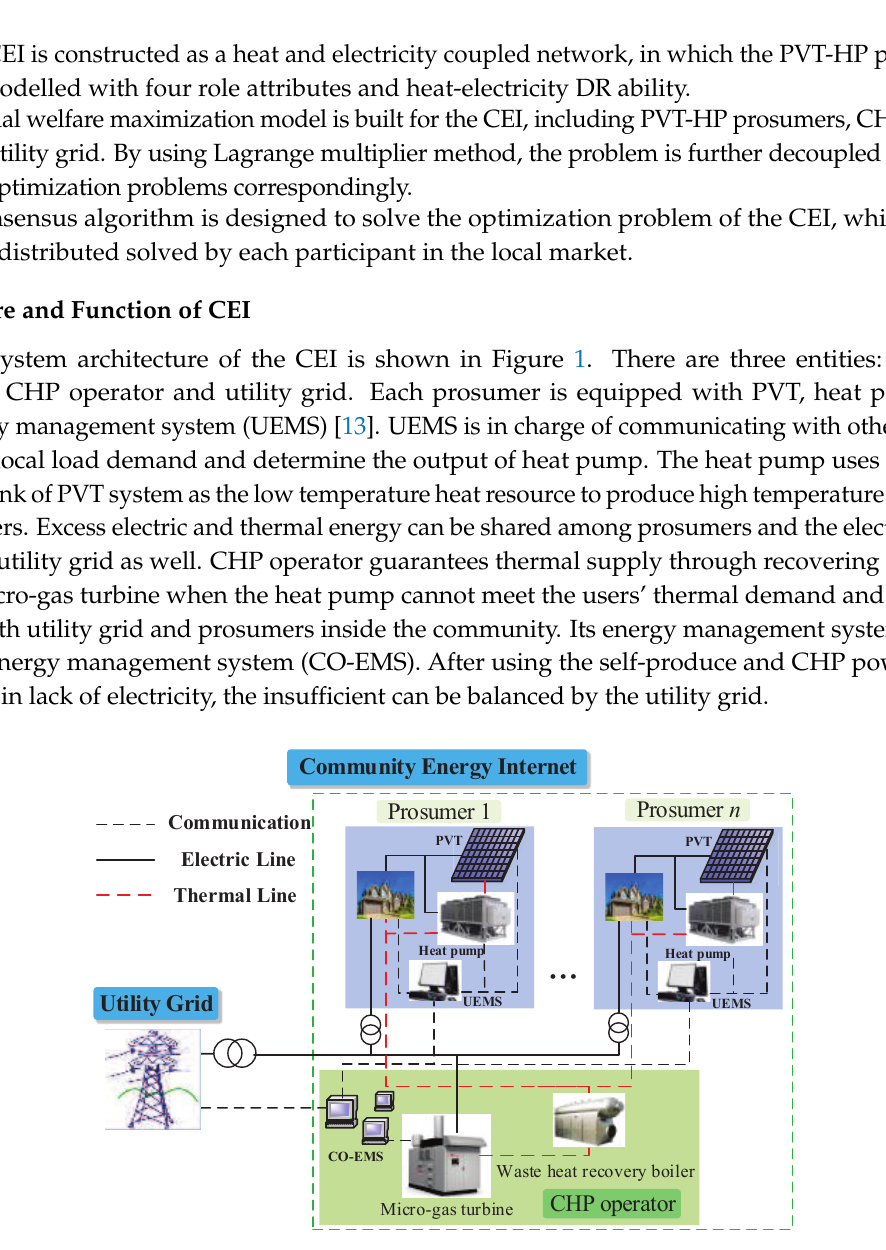
Figure 1. Structure of Community Energy Internet (CEI) with photovoltaic-thermal and heat pump (PVT-HP)